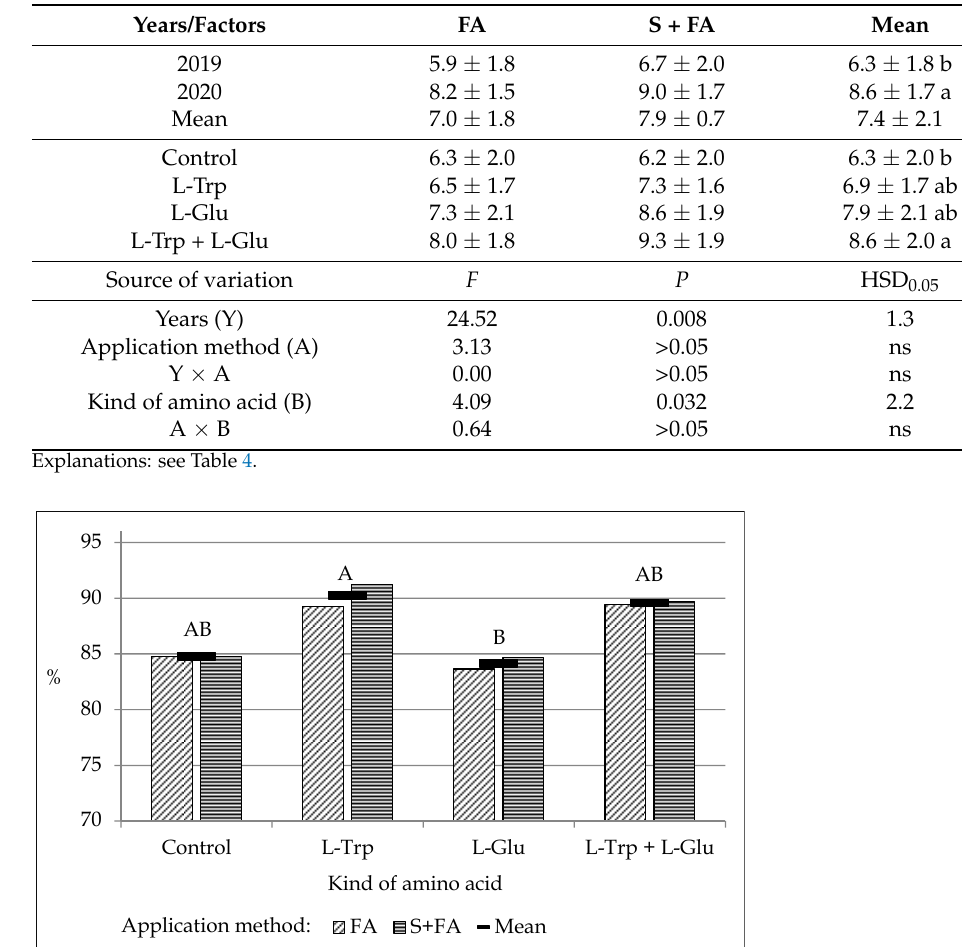
Figure 3. Harvest index of carrot, on average across two years (2019–2020); FA—foliar application, S + FA—soil and foliar application, L-Trp—L-tryptophan, L-Glu—L-glutamic acid; and means (n = 3) followed by different letters in differ significantly at p ≤ 0.05.